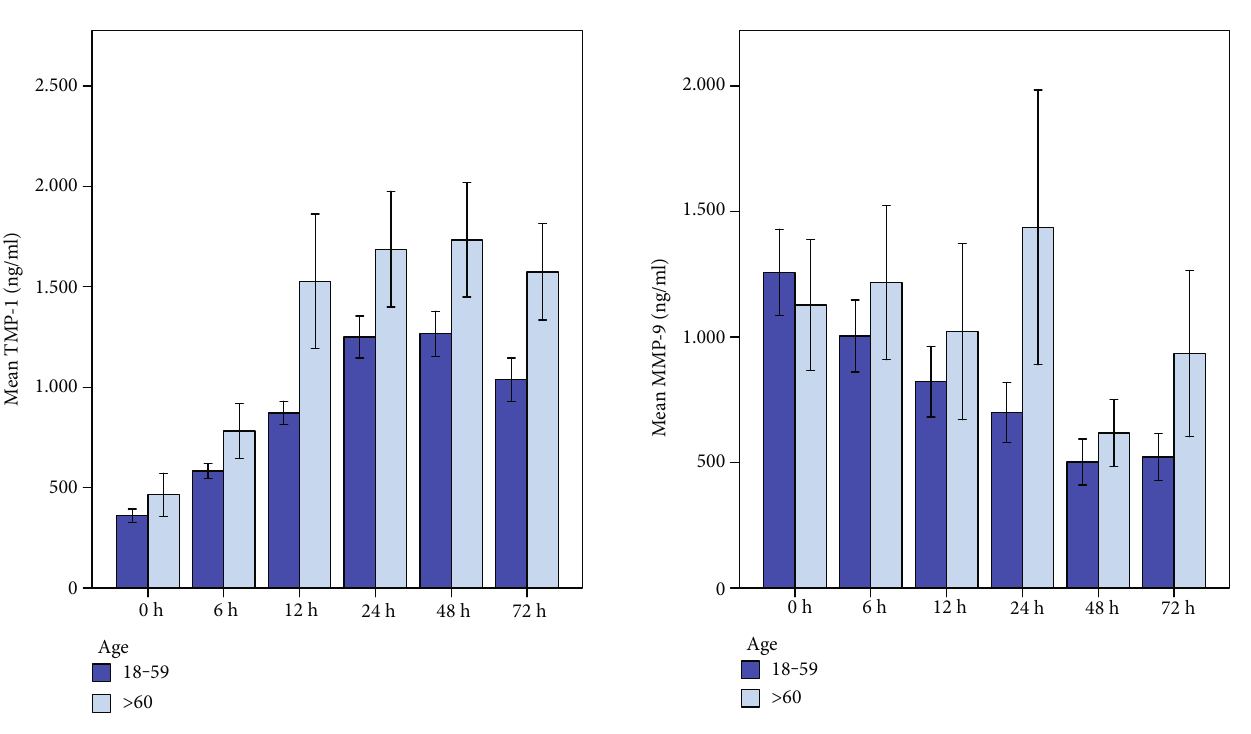
Figure 6: TIMP-1 serum levels within the fi rst 72h after trauma correlated to patient ’ s age. Multivariate testing of TIMP-1 serum levels and time after trauma revealed a highly statistical signi fi cance ( p < 0 : 001 ) in both groups. TIMP-1 levels were signi fi cantly higher in patients ≥ 60 years when compared to younger polytrauma patients ( p = 0 : 008 ). Post hoc analysis revealed signi fi cantly higher TIMP-1 levels in older patients after 72h ( p = 0 : 039 ).